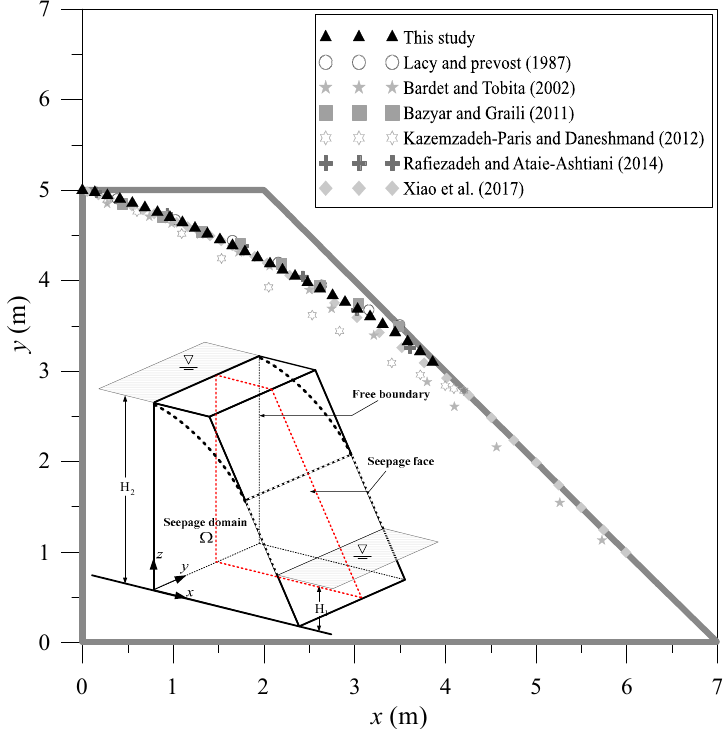
Figure 16. Comparison of the computed results for a trapezoidal dam on profile